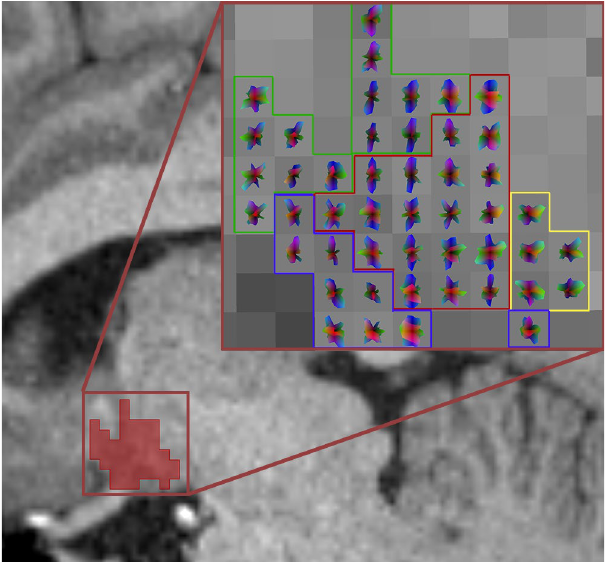
Figure 1. Visualization of the diffusion orientation distribution functions (ODF) and the corresponding clusters (large rectangle, anterior–superior in green, anterior-inferior in blue, intermediate in red, posterior in yellow) in a CSF- and FA-thresholded sagittal slice of the total hypothalamus (small rectangle, lateral view to display all clusters). Color-coding of the ODFs represents the probability of orientation in the given direction at each point of the surface: red for right–left, green for rostral–caudal, blue for